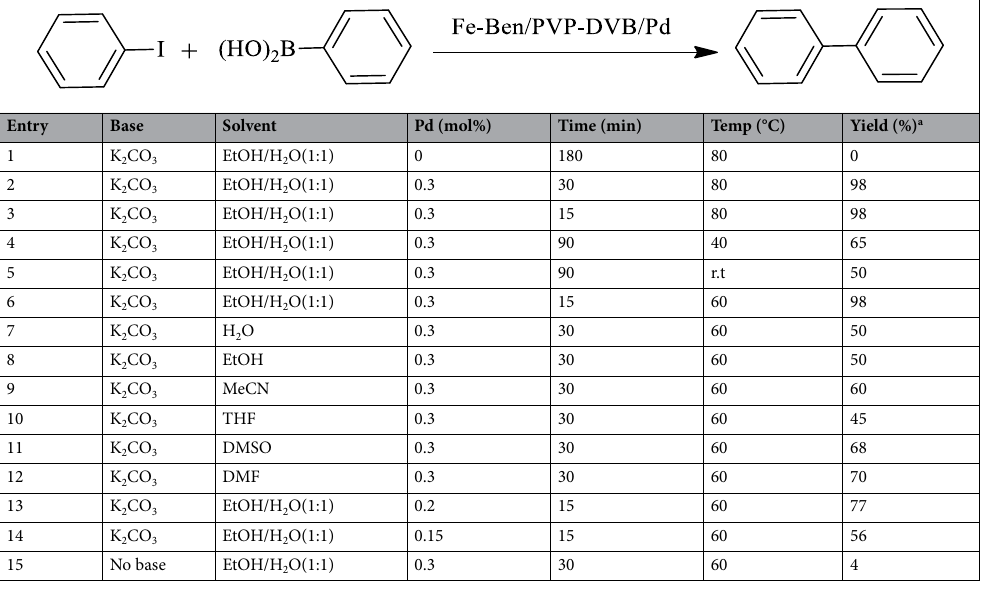
Table 1. Optimized Suzuki ‐ Miyaura coupling reaction conditions. Reaction condition: phenylboronic acid (0.6 mmol), base (0.4 mmol), Iodobenzene (0.5 mmol), solvent (2 mL), nanocatalyst (0.3 mol%). a Isolated